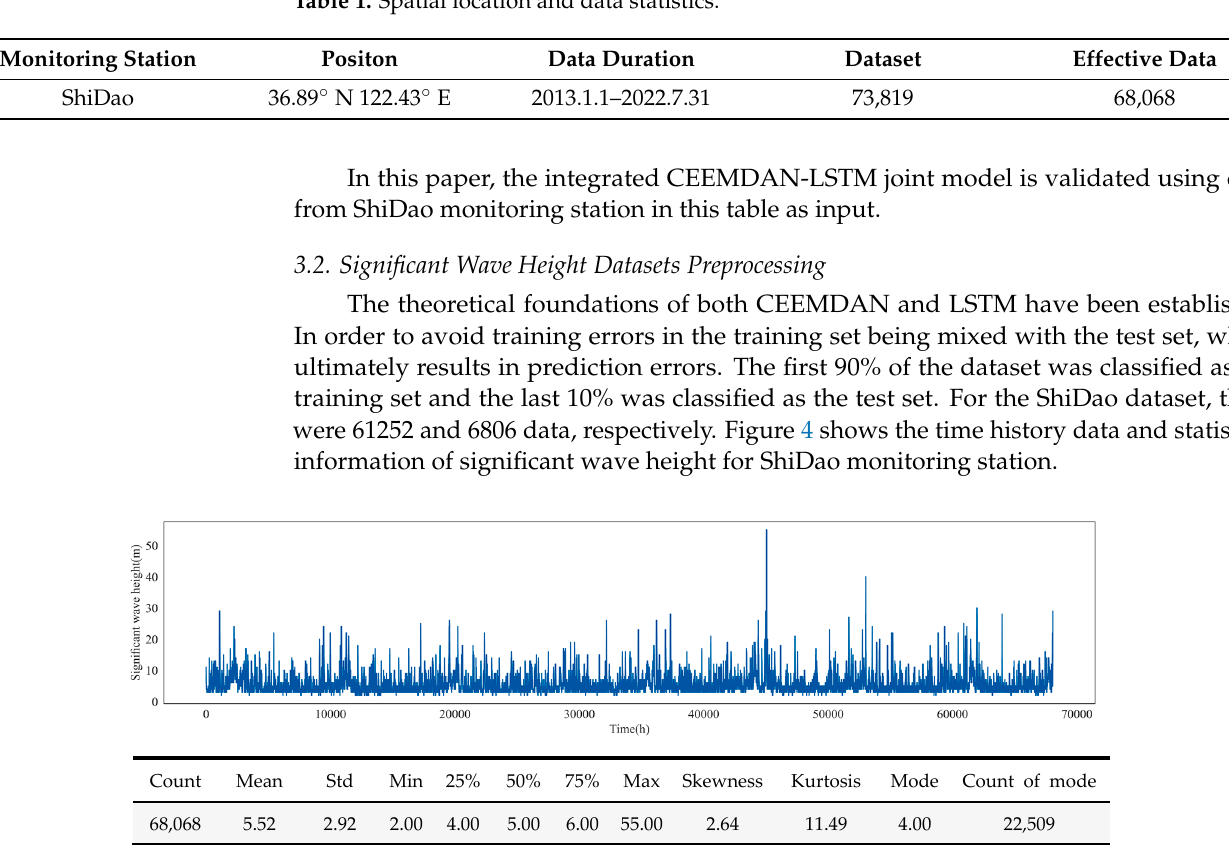
Figure 4. Significant wave height time series of ShiDao effective data.